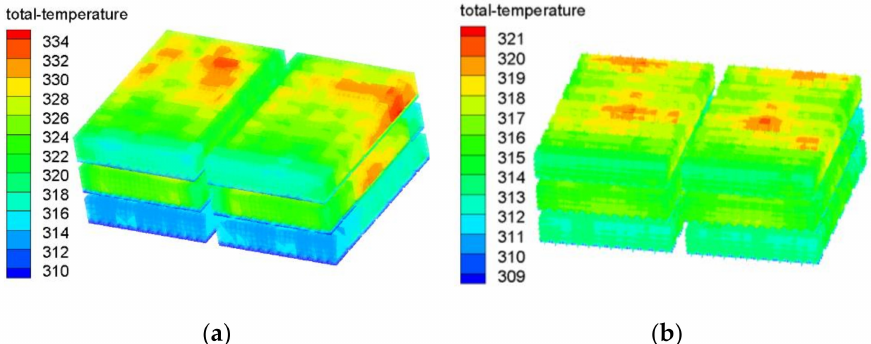
Figure 23. Nephograms of battery pack temperatures: ( a ) temperature of battery pack before opti- mization; and ( b ) temperature of the battery pack after